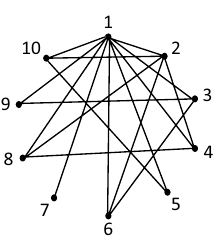
Fig. 1 Maximal divisor graph of order